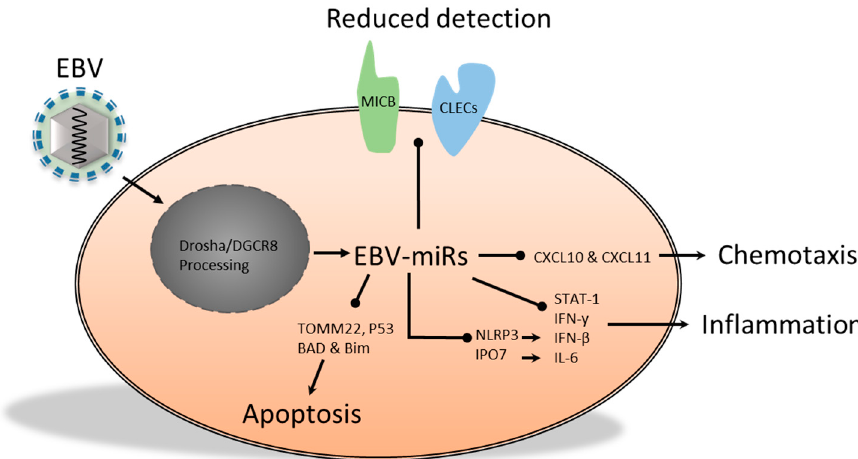
Figure 2. EBV miRs can alter the expression of multiple proteins, cytokines and chemokines in various cell types. These alterations may benefit pathogen persistence by affecting key pro-inflammatory processes, such as: detection by natural killer (NK) cells and cytotoxic T lymphocytes (CTLs), cytokine signaling, chemotaxis and apoptosis. MICB, CLECs, CXCL10, IPO7, Bim and TOMM22 have been verified as vmiR targets by reporter assays and PAR-CLIP analysis, while CXCL11, P53, BAD and NLRP3 have only been verified by reporter assays. MICB, MHC class I-related chain B; CLECs, C-type lectin domain family members; DGCR8, DiGeorge syndrome critical region gene 8; TOMM22, translocase of outer mitochondrial membrane 22 homolog; STAT, signal transducers and activators of transcription; BAD, Bcl-2-associated death promoter; Bim, Bcl-like protein 11; IPO7, importin 7; CXCL, chemokine (C–X–C motif) ligand; NLRP3, NLR family, pyrin domain containing 3.